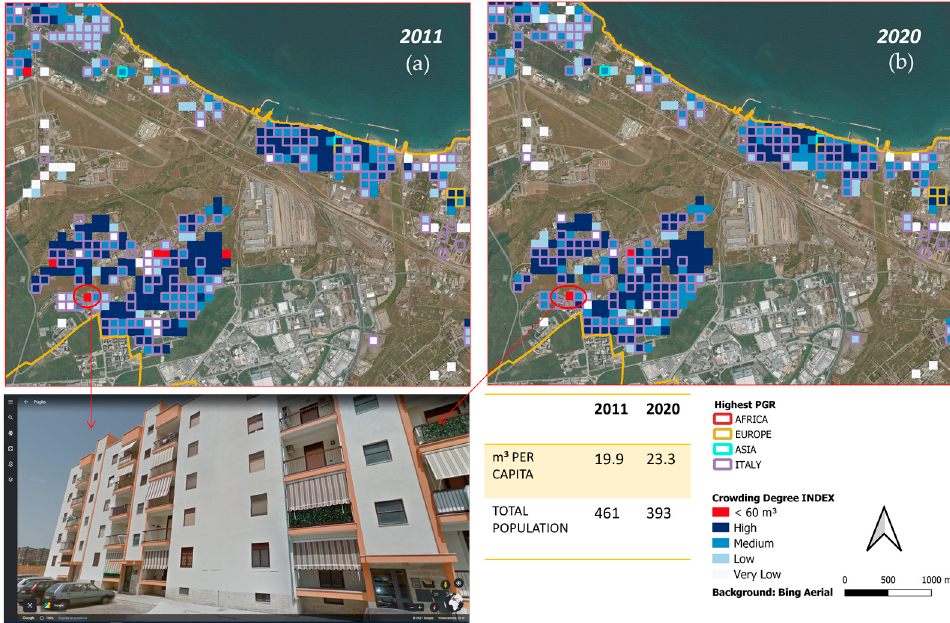
Figure 21. Close-up of overcrowding degree map in St. Paolo District in: ( a ) 2011 and ( b ) 2020; specific building data (bottom).